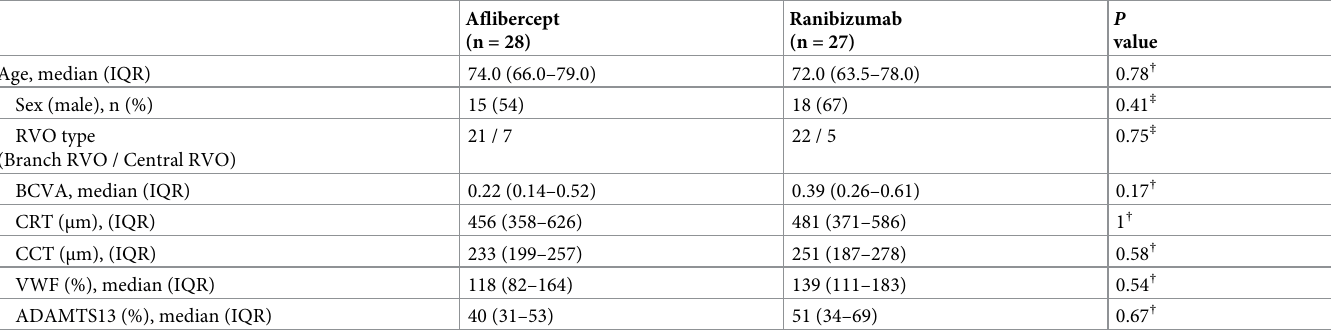
Table 2. Basic characteristics of patients with RVO classified according to anti-VEGF